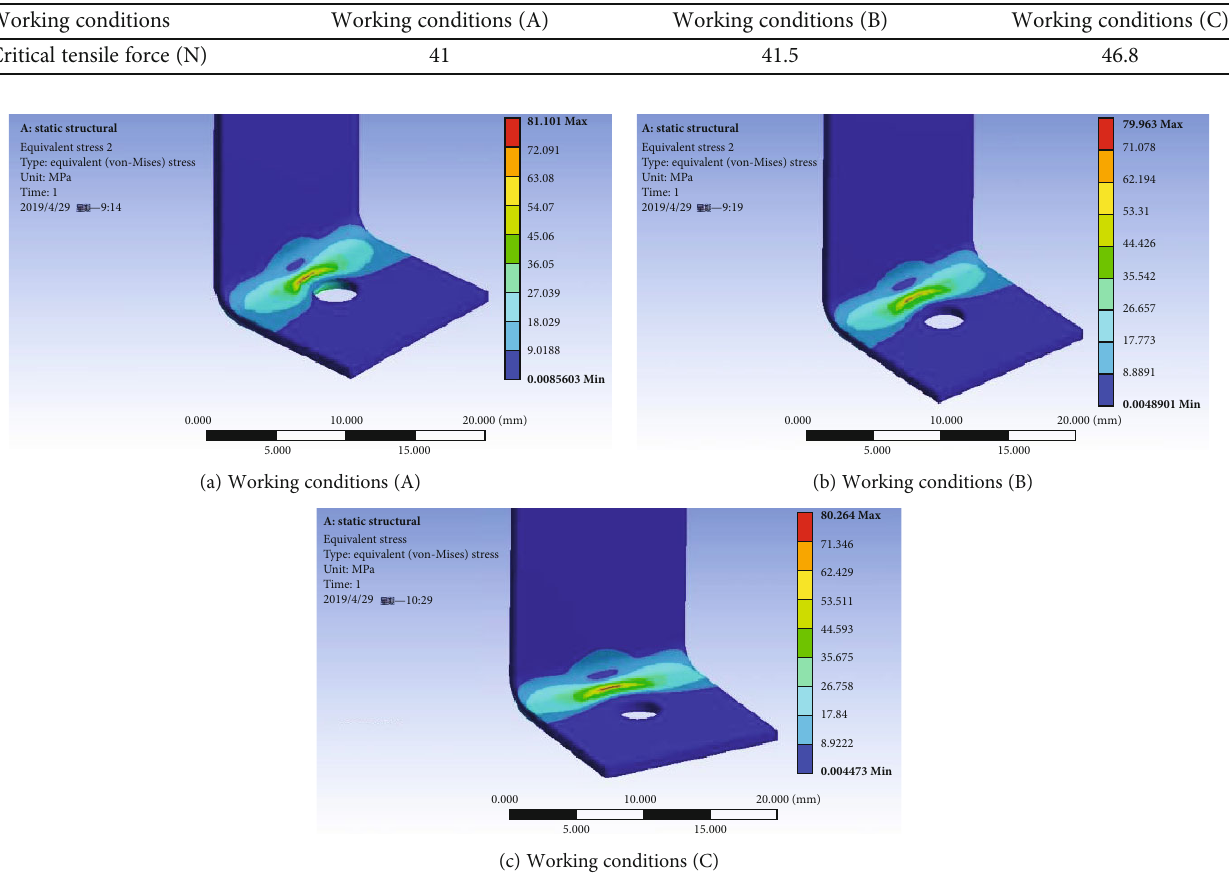
Figure 20: Stress cloud map corresponding to the change of diameter of the riveting joint in nylon